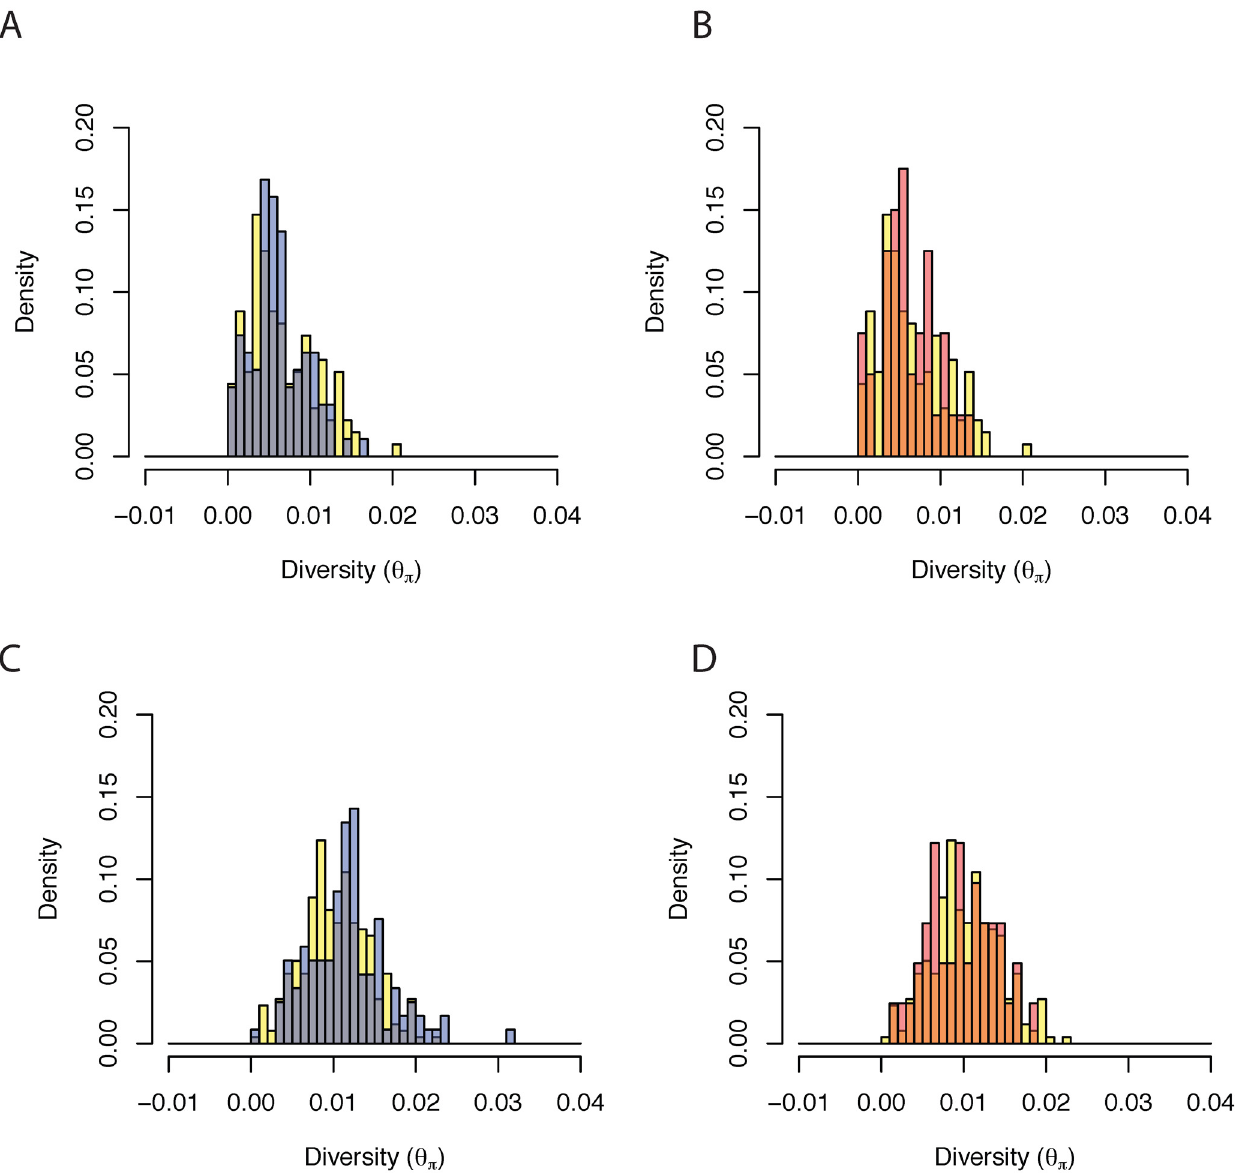
Fig 4. Histogram of nucleotide diversity, θ π , (A) For Intergenic mutations (yellow) and duplications that capture gene sequences but do not create chimeric constructs (blue) in D. yakuba . (B) For Intergenic mutations (yellow) and duplications that create chimeric genes (red) in D. yakuba . (C) For Intergenic mutations (yellow) and duplications that capture gene sequences but do not create chimeric constructs (blue) in D. simulans . (D) For Intergenic mutations (yellow) and duplications that create chimeric genes (red) in D. simulans